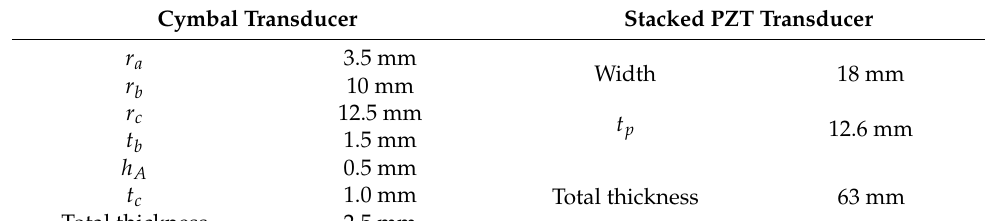
Figure 10. Acoustic properties of a cymbal transducer according to various parameters ( a ) 𝑡 (cid:3029) , ( b ) 𝑟 (cid:3028) , ( c ) 𝑟 (cid:3029) , and ( d ) ℎ (cid:3002) .